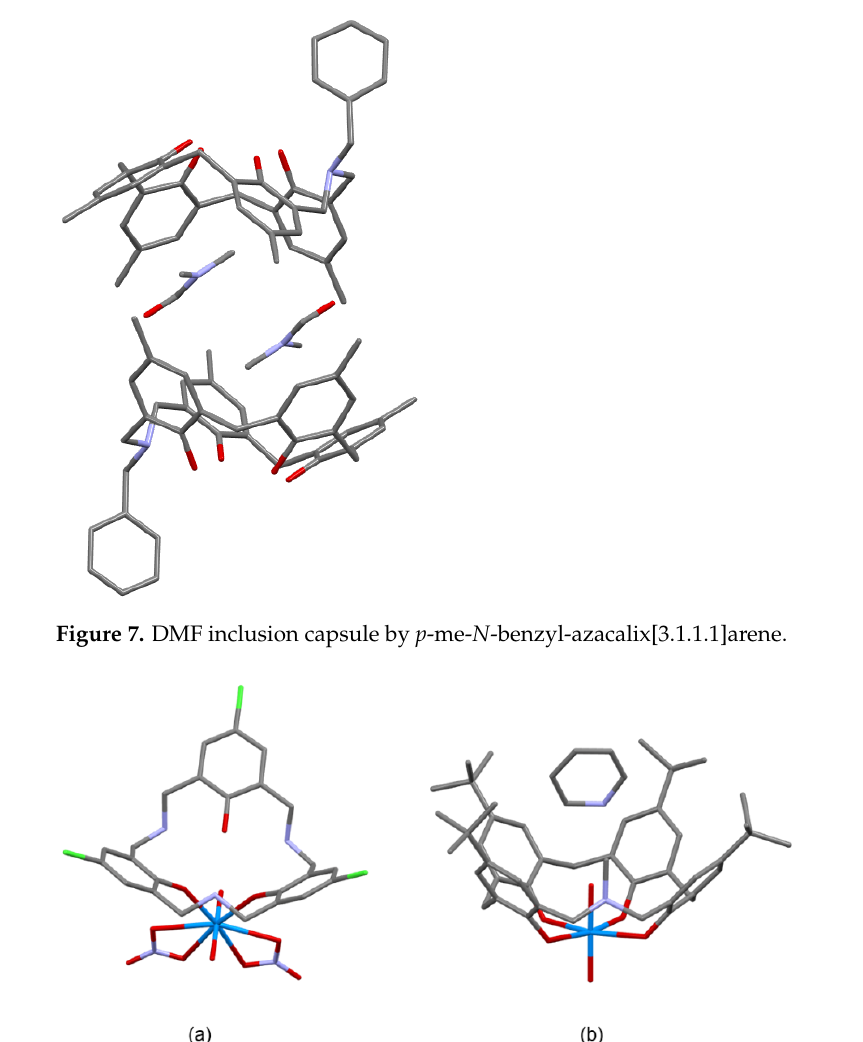
Figure 8. Structures of the metal complexes of the azacalixarenes. ( a ) UO 22+ [ p -Cl- N -benzyl- triazacalix[3.3.3]arene]. ( b ) UO 22+ [ p-tert -butyl- N -methyl-azacalix[3.1.1.1]arene]∙pyridine inclusion complex. Benzyl side chains are omitted for clarity.